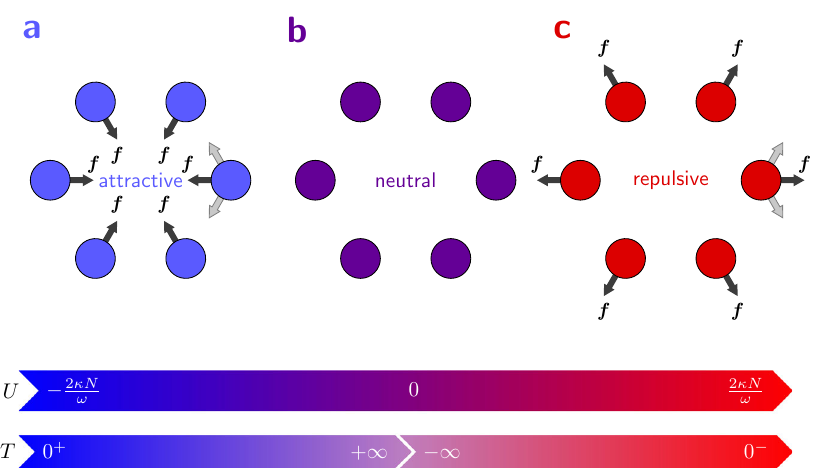
Fig. 4 Pressure in a circular arrangement of waveguides having periodic boundary conditions. a Attractive, b zero, and c repulsive forces in circular discrete optical systems. The light gray arrows (shown indicative only on the waveguide located to the right) represent forces exerted due to the interwaveguide pressures. The vectorial sum of these forces in each waveguide are depicted with black arrows. When U < 0 and thus T > 0, the forces are attractive, whereas when U > 0 and thus T < 0, the forces are repulsive. In between, we have U = 0 and T = ± ∞ leading to zero net interwaveguide